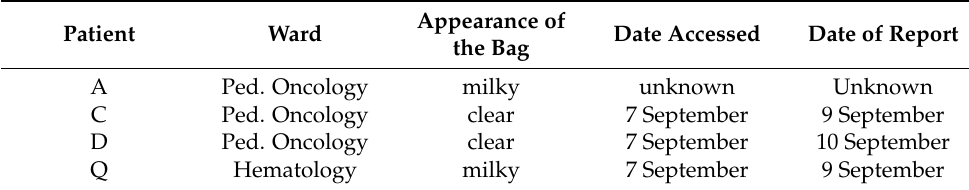
Table 3. List of parenteral nutrition bags analyzed by Bacteriology 2.